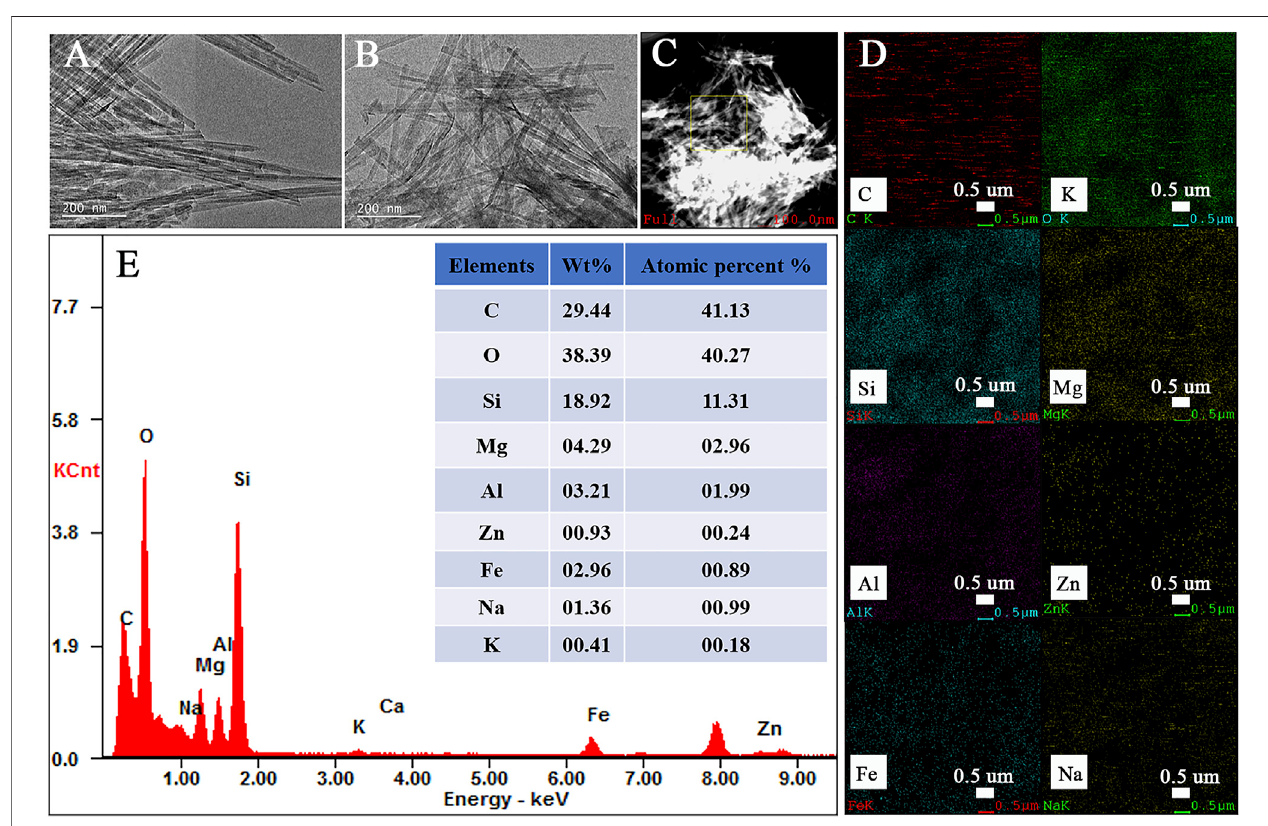
FIGURE 3 | TEM of Pal (A) , the elemental mappings (B – D) of various elements and EDS spectrum of Zn(II)-Cur/Pal hybrid material ( E ).